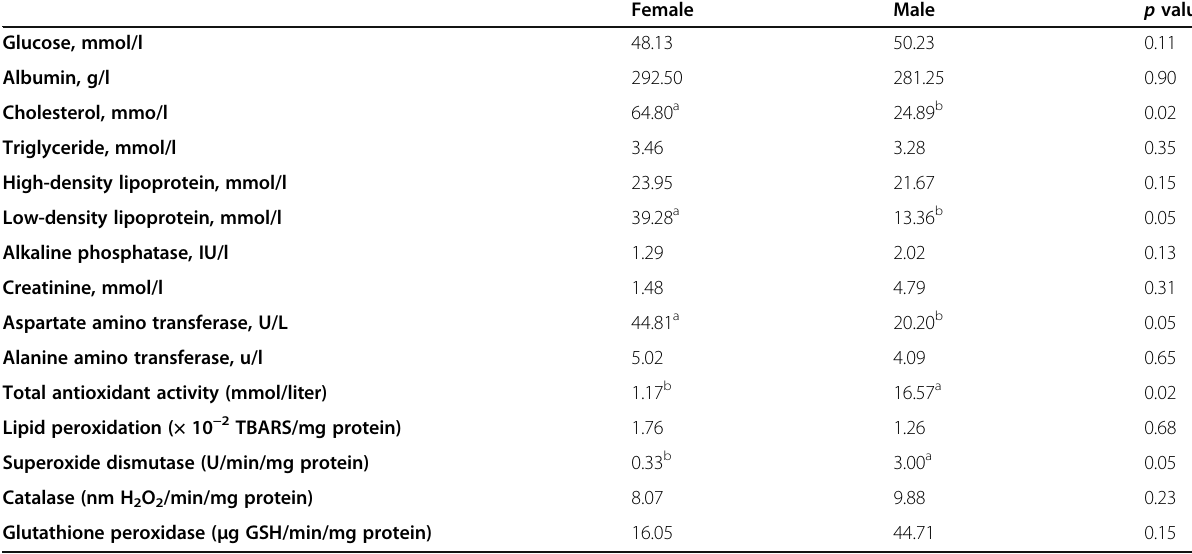
Table 2 Sexual dimorphism in metabolic and antioxidant status of Heterobranchus longifilis